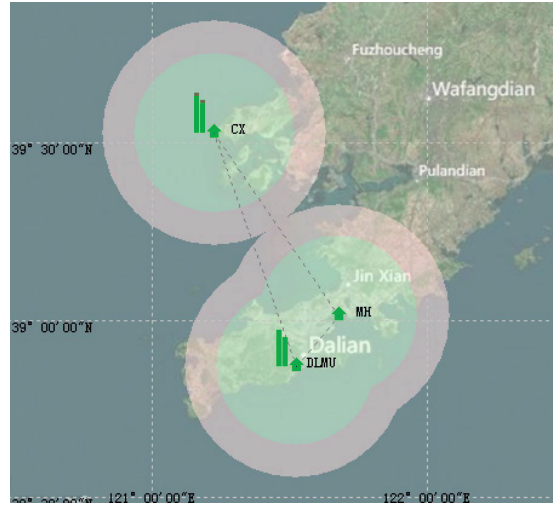
Figure 13. Signal coverage of DLMU-CORS.